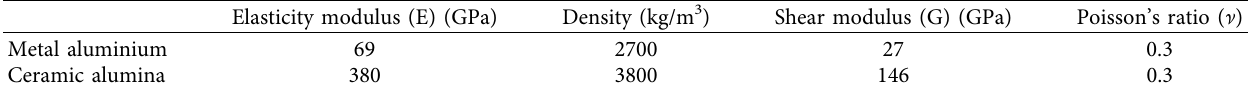
Table 2: Material parameters of the FGH sandwich